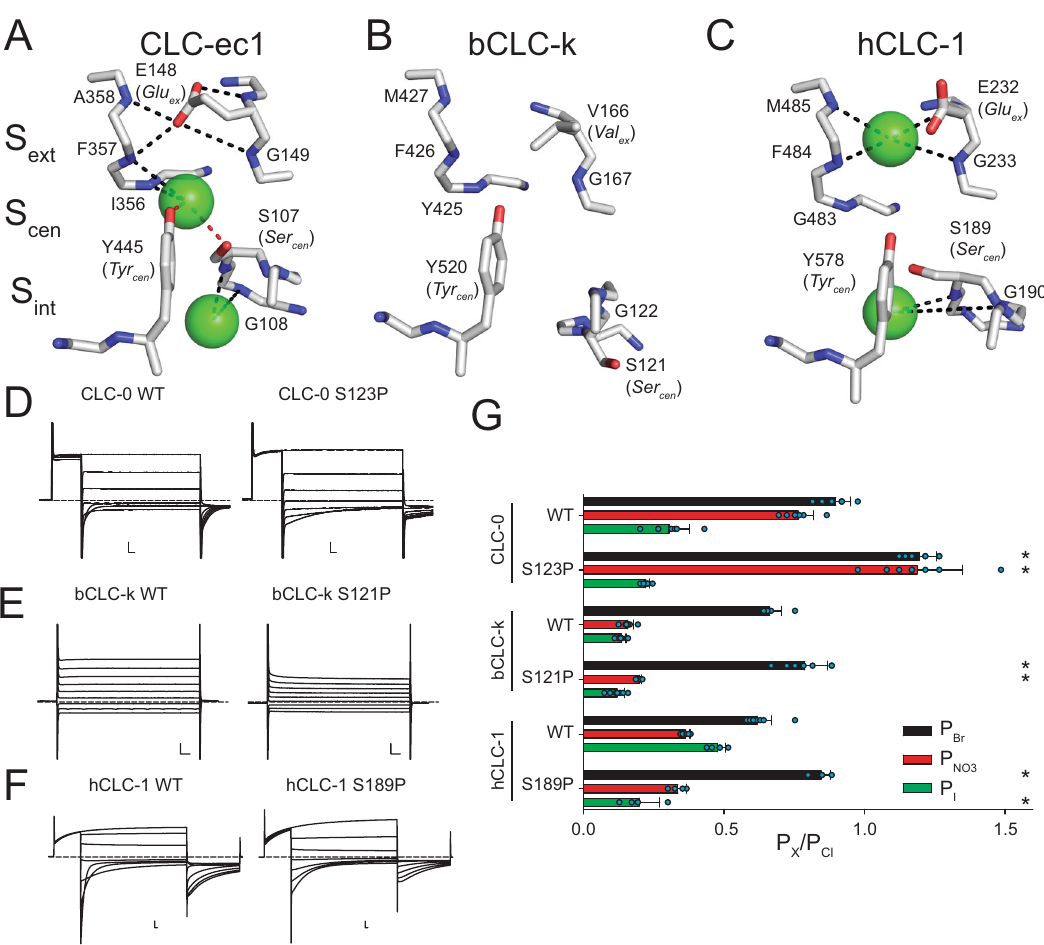
Fig. 1 | Structural architecture and ion coordination in the Cl − pathway of CLC channels and transporters. Close up view of the Cl − permeation pathway in CLC- ec1(PDB:1OTS, A ),bCLC-k(PBD:5TQQ, B )andCLC-1(PDB:6COY, C ).Theposition of the external (S ext ), central (S cen ) and internal (S int ) binding sites is identi fi ed based on the crystal structure of CLC-ec1 31 . Bound Cl − ions are shown as green spheres. No ions were resolved in the bCLC-k structure 33 . Dashed lines indicate hydrogen bonds between the Cl − ions and side chains (red) or backbone amides (black) 31,34 . Representative current traces of WT and proline mutants at Ser cen in CLC-0 ( D ), bCLC-k ( E ) and hCLC-1 ( F ). Dashed lines indicate the 0 current level.